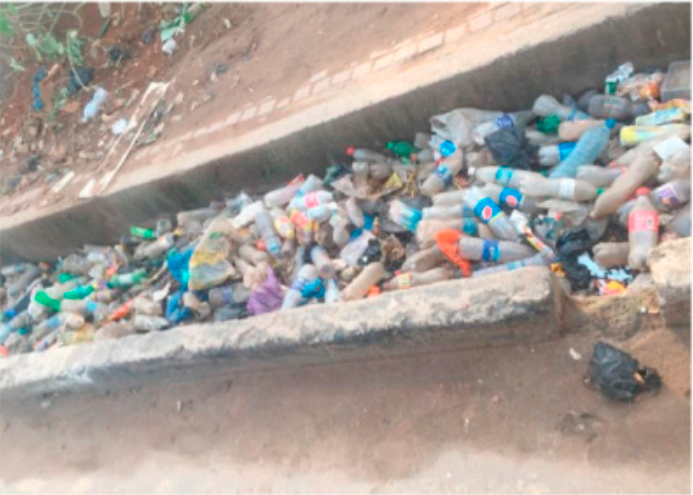
Figure 5. Plastic waste blocking drains in Nigeria